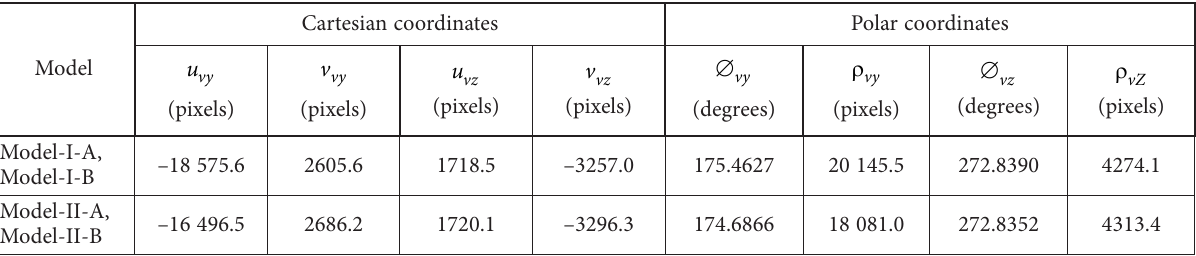
Figure 13. Histograms for angle coordinates of two orthogonal VPs for Camera-III Table 3. Image cartesian and polar coordinates of vanishing points for Camera-I